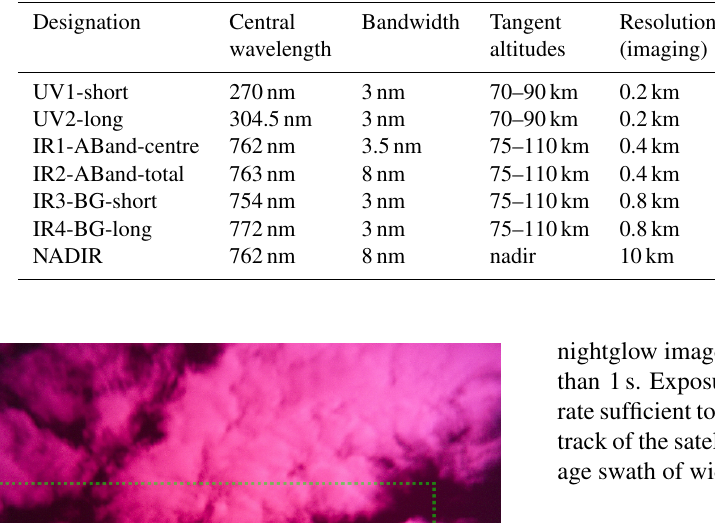
Table 4. Overview of optical properties of the MATS limb and nadir channels. The image resolution of the channels is specified in two ways: imaging refers to the imaging quality of the optics in terms of the full width at half maximum of the point spread function, and binning refers to the size of the recorded image pixels after nominal binning on the CCD. Pixel sizes are given as vertical × horizontal for the limb channel, and as across track × along track (including motion blur) for the nadir channel.